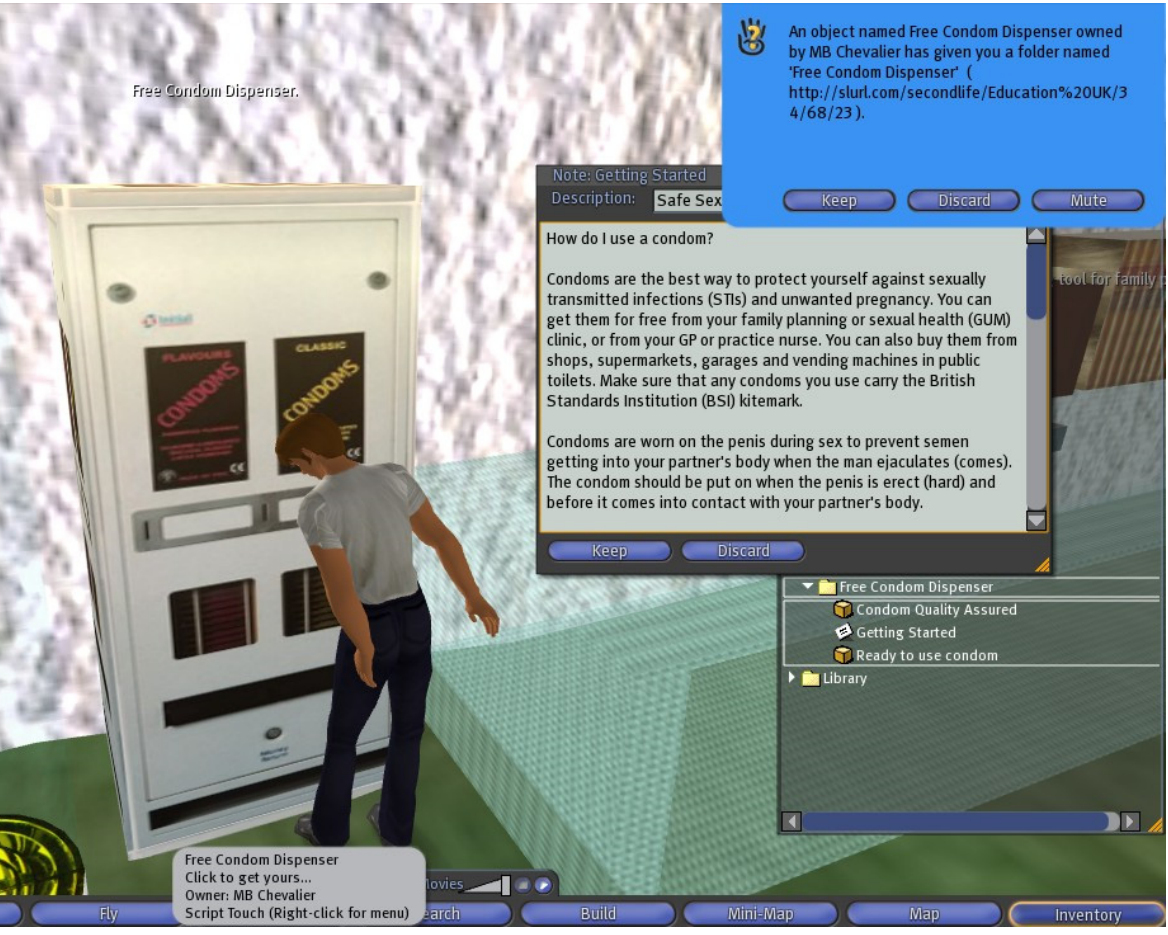
Figure 6. A ‘raising awareness’ edutainment artefact at the University of Plymouth Sexual Health SIM in Second Life ® [13]. This free virtual condom dispenser dispenses two 3D male condom objects to user’s inventory, plus an information Notecard on how to use a (real) male